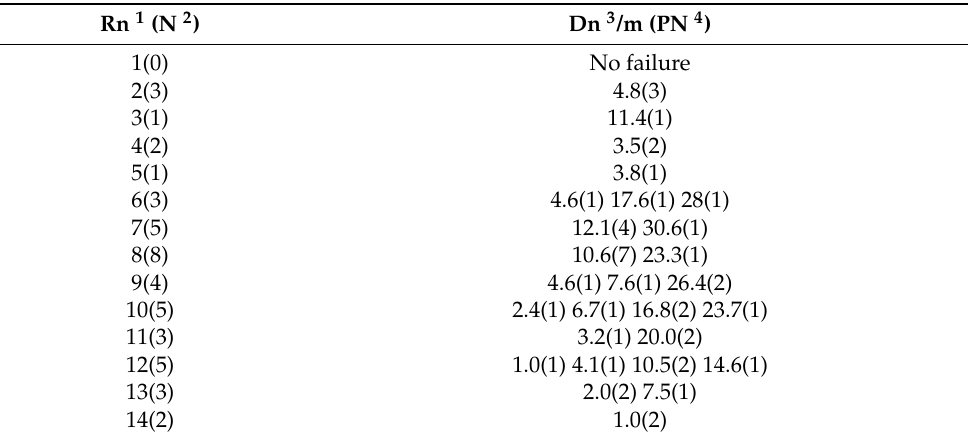
Table 2. Failure information of Test_1.